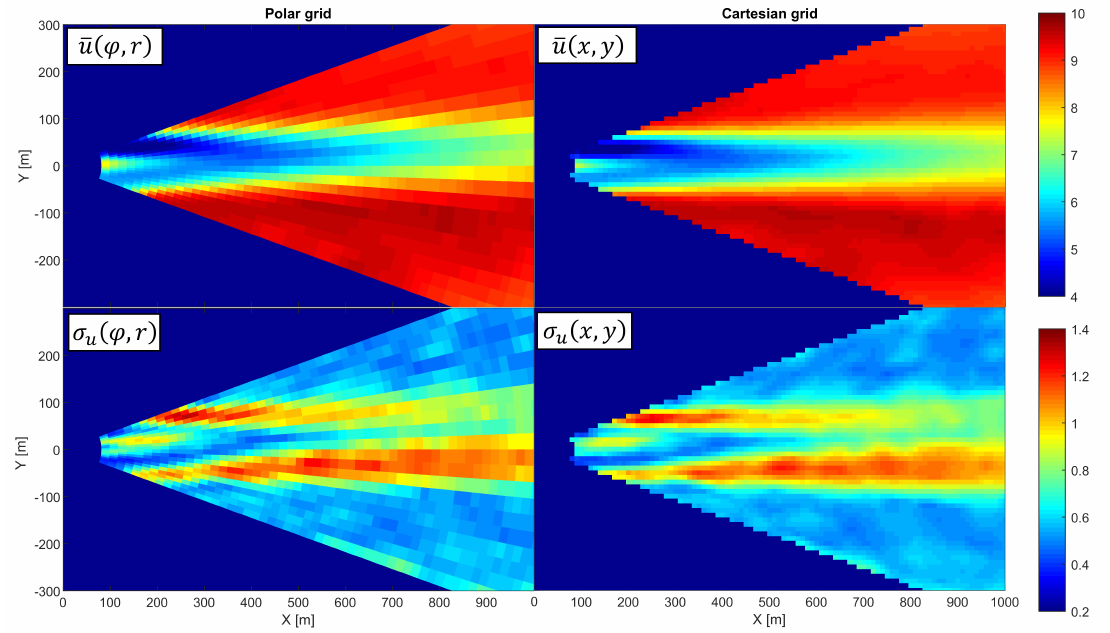
Figure 7. Example of the average and standard deviation of the wake in polar and Cartesian coordinates. 22h30–23h00, 15 September 2017. Units in